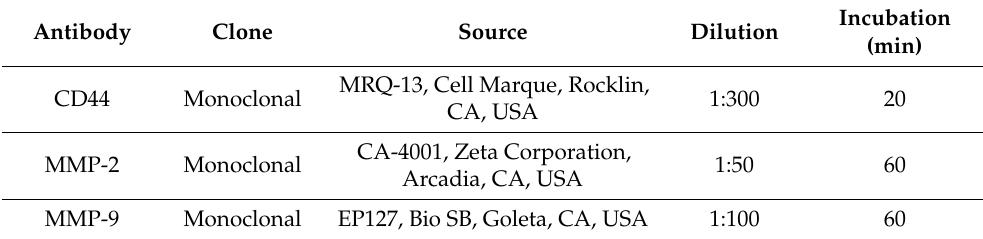
MRQ-13, Cell Marque, Rocklin, CA, USA CA-4001, Zeta Corporation,